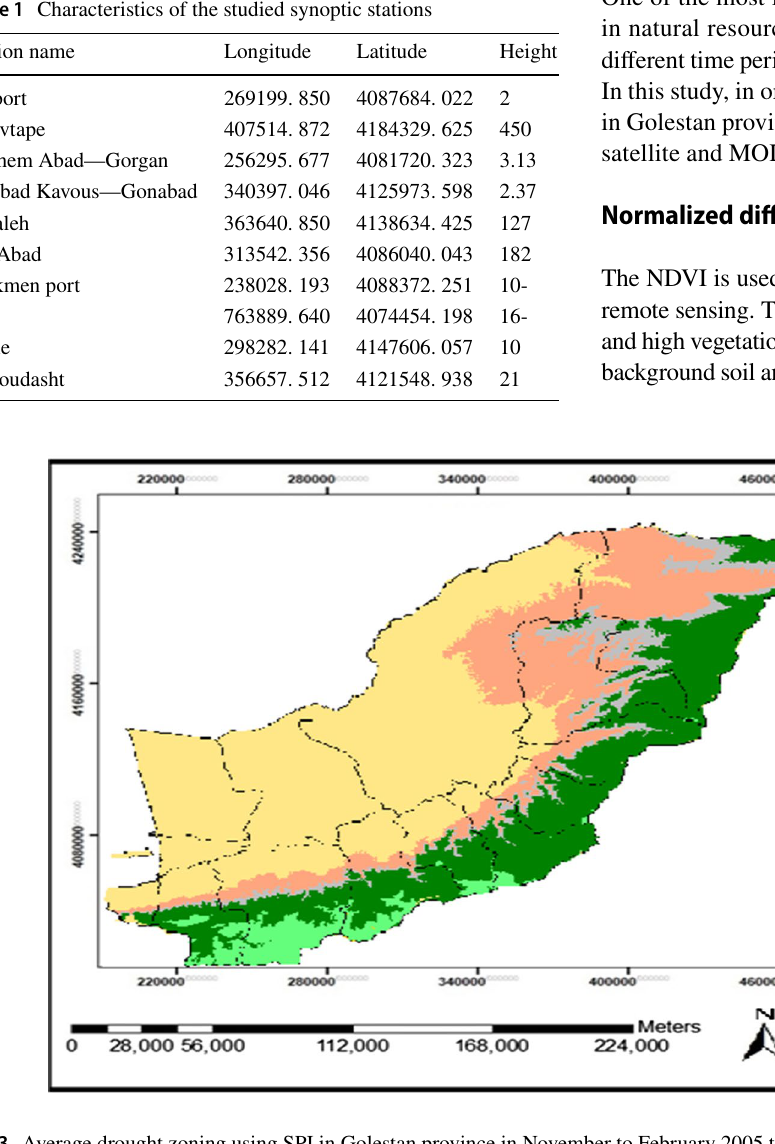
Fig. 3 Average drought zoning using SPI in Golestan province in November to February 2005 to